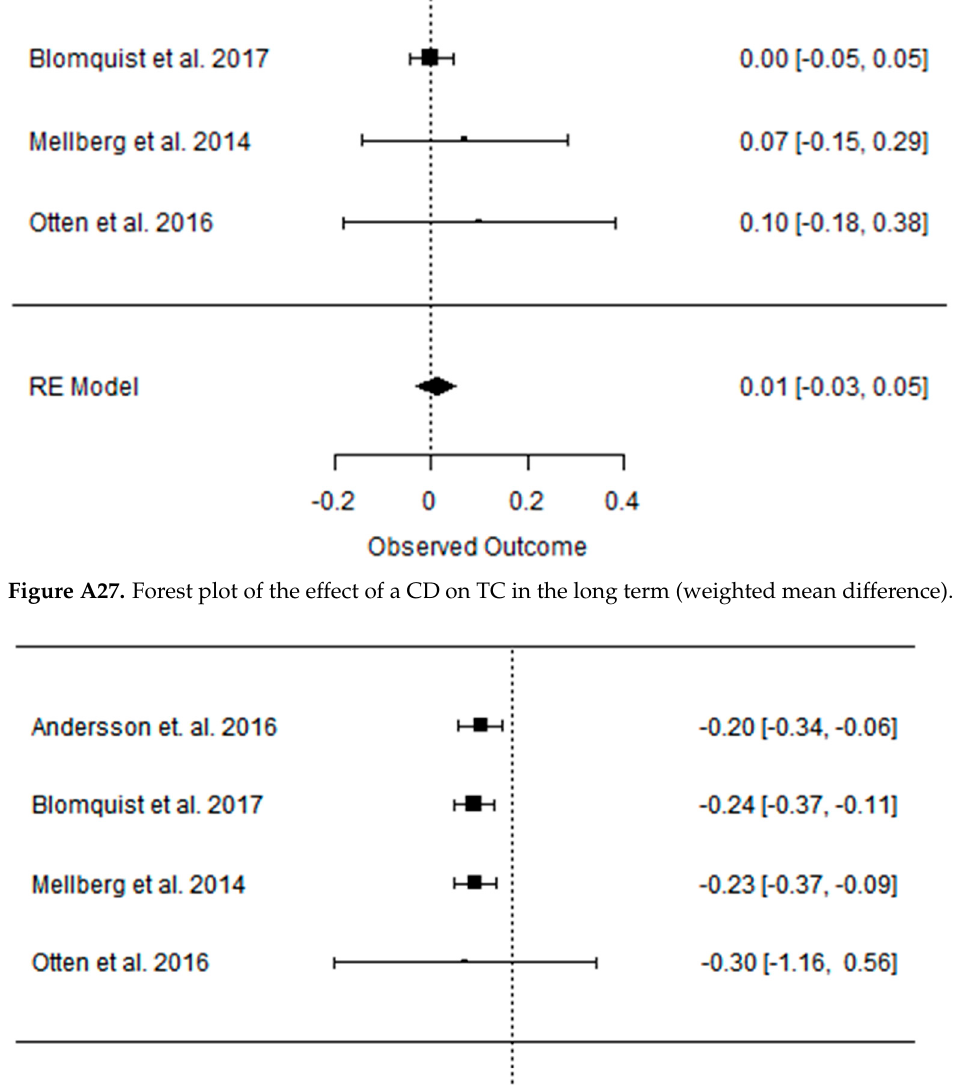
Figure A26. Forest plot of the effect of a PD on TC in the long term (weighted mean difference).